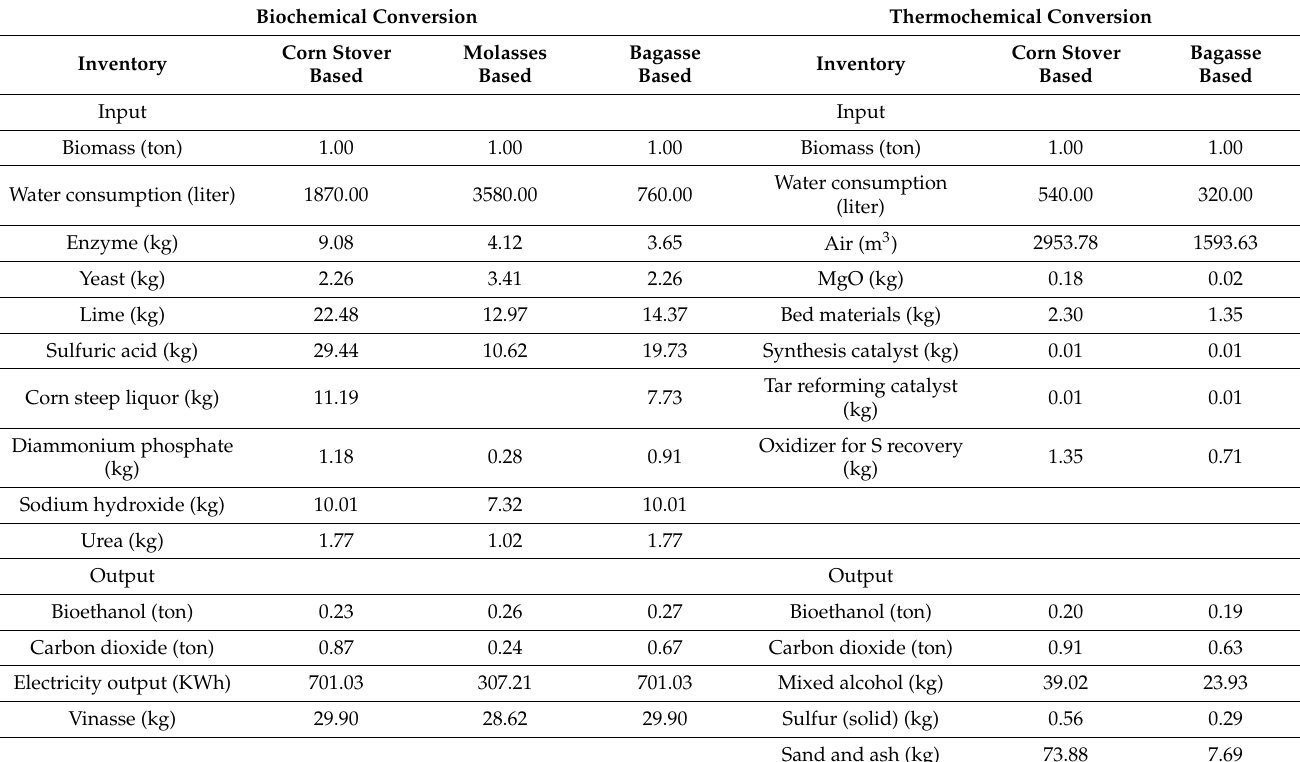
Table 3. Material and energy inputs and outputs in biochemical and thermochemical conversions of molasses/corn